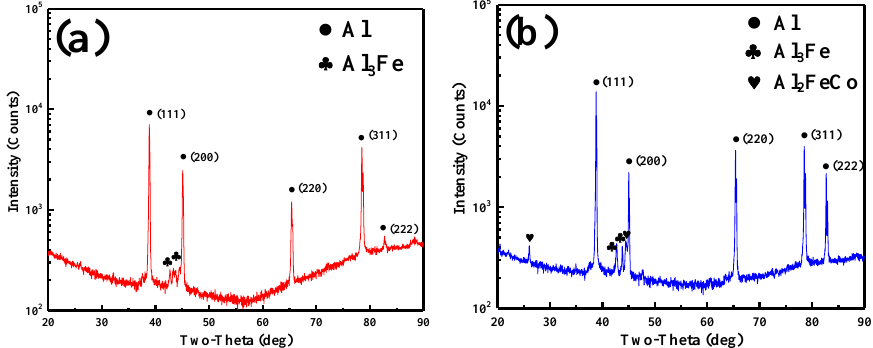
Figure 2. XRD patterns of the alloys subject to different conditions: ( a ) as-cast Al-2Fe; ( b ) as-cast Al- 2Fe-0.8Co.